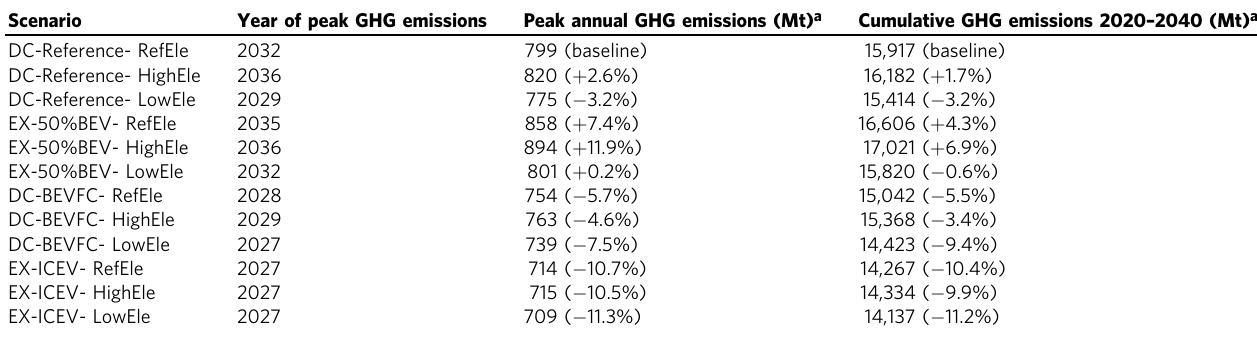
Table 4 Peak and Cumulative GHG emissions under three electricity GHG intensity